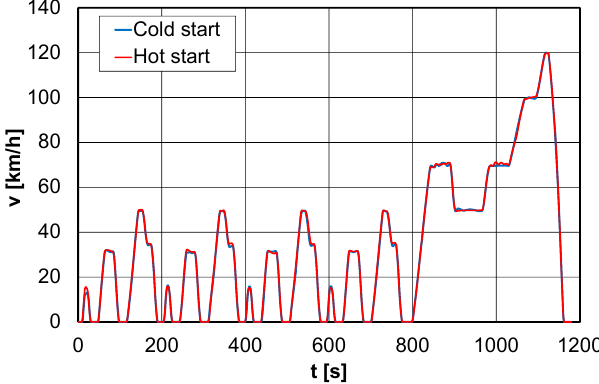
Figure 2. Vehicle speed curve (v) for cold and hot engine start.